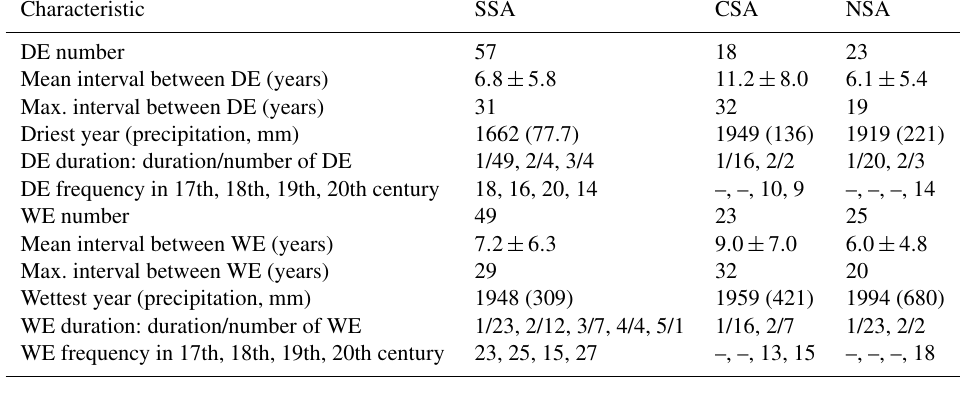
Table 3. Characteristics of drought events (DEs) and wet events (WEs) identified based on the precipitation reconstructions.